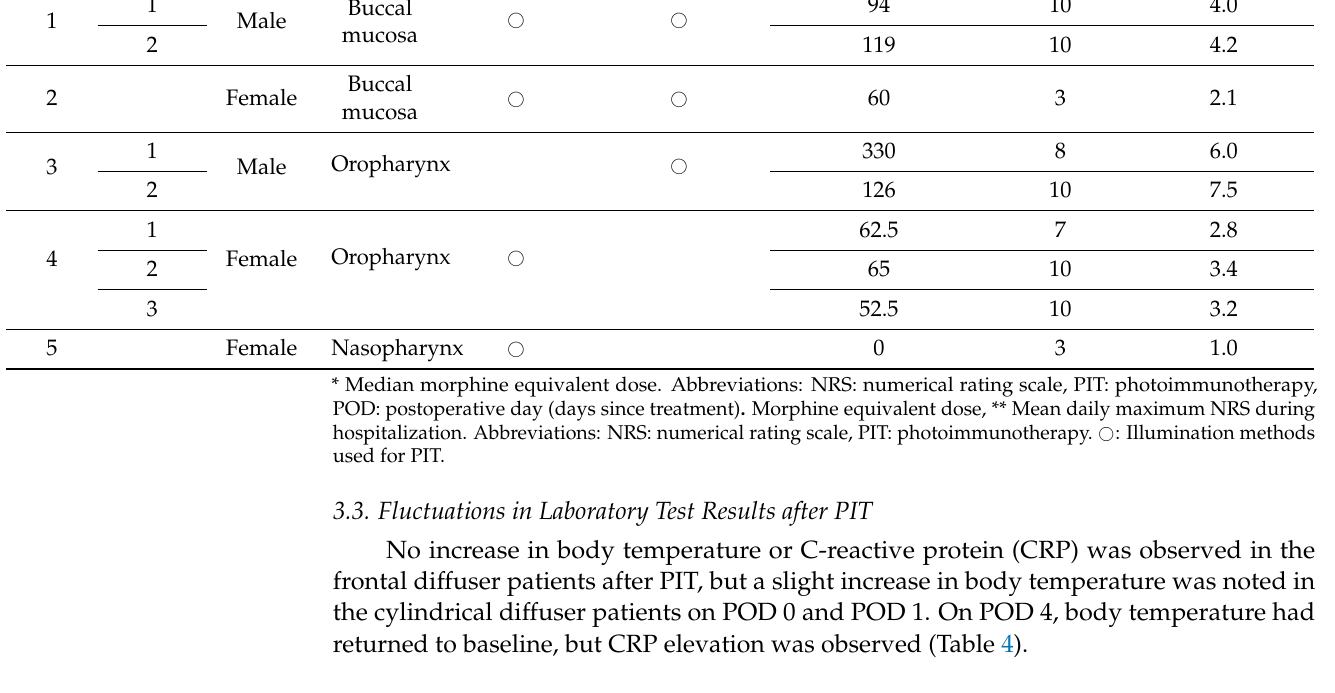
Table 4. Clinical laboratory test results during